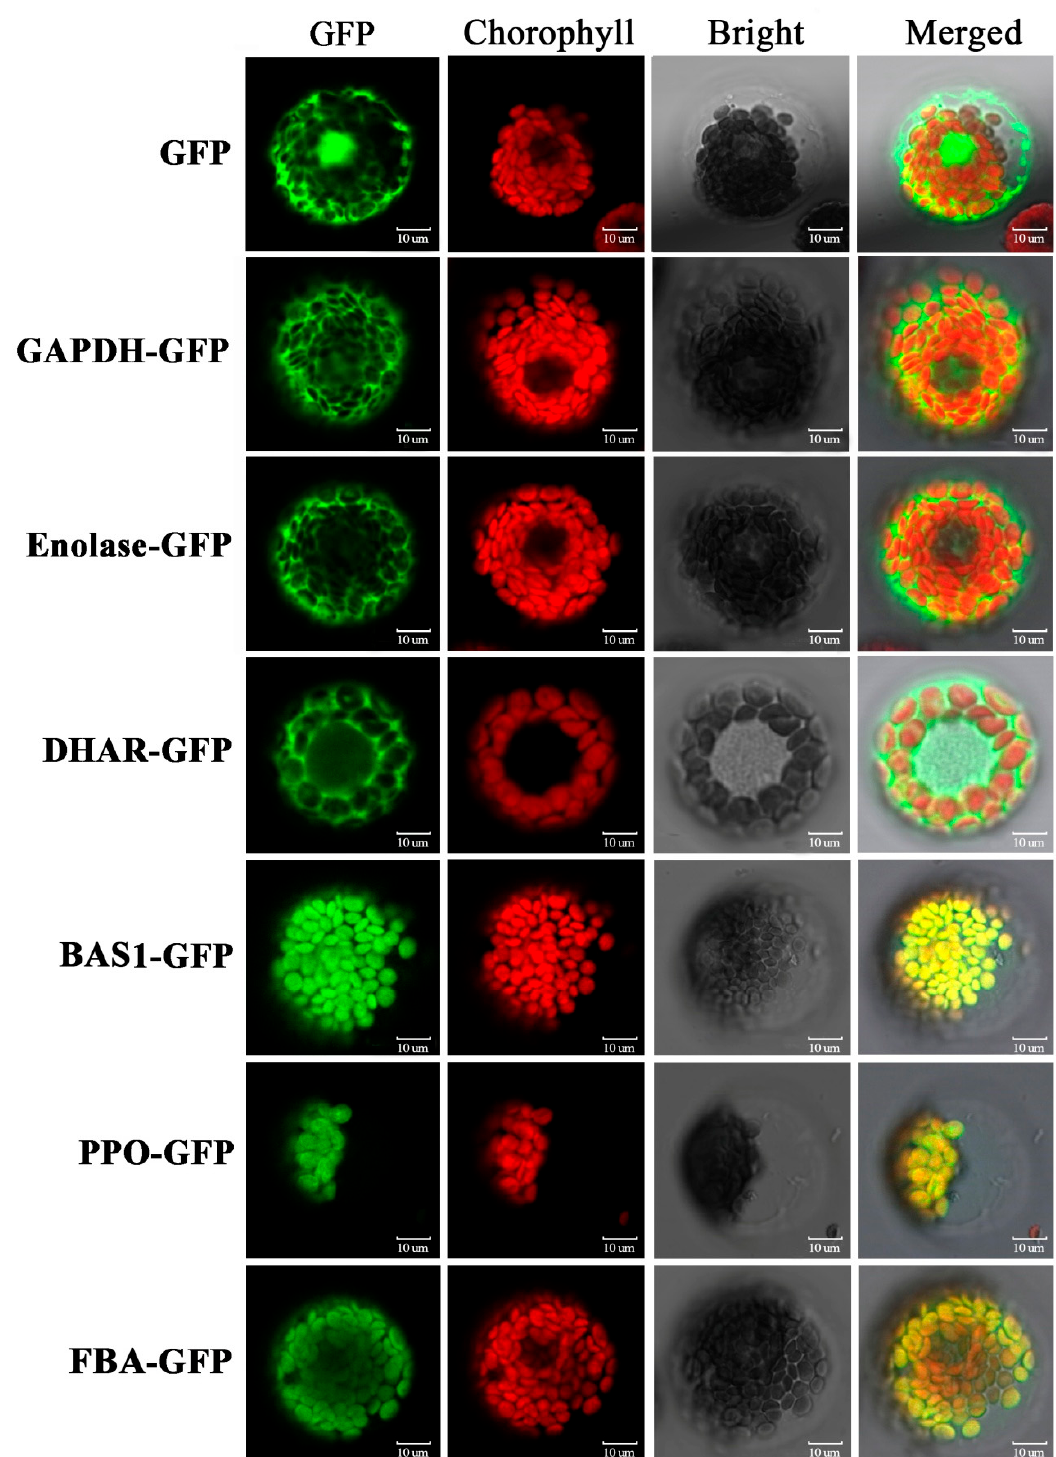
Figure 5. Subcellular localization of selected differentially accumulated proteins (DAPs) by wheat protoplast transformation. GFP: green fluorescent protein signal; Chlorophyll: chlorophyll auto-fluorescence signal; Bright light: bright light field; Merged: combination of GFP, chlorophyll, and bright light. GAPDH, glyceraldehyde 3-phosphate dehydrogenase; DHAR, dehydroascorbate reductase; BAS1, 2-cys peroxiredoxin BAS1; PPO, polyphenol oxidase; FBA, fructose-1,6-bisphosphate aldolase; GFP, negative control.